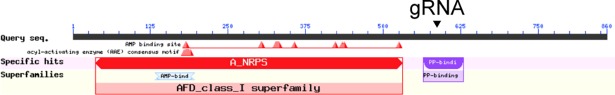
NCBI conserved domain search results for the ebony protein.The location of the gRNA relative to the mature protein sequence is indicated.